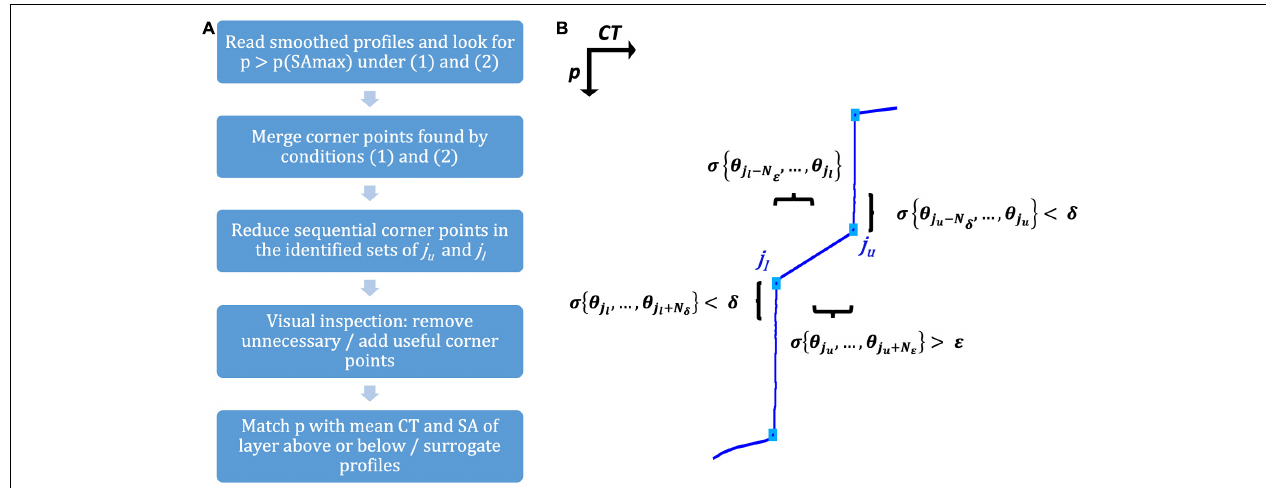
FIGURE 2 | (A) Outline of the interface detection procedure, indicating the main steps. (B) Detail of a CT profile with staircases illustrating the conditions (1) and (2) explained in Section “Detection of Interfaces” used to detect corner points j u and j l ; N δ and N ε are the set of points adjacent to points j u and j l where the two conditions